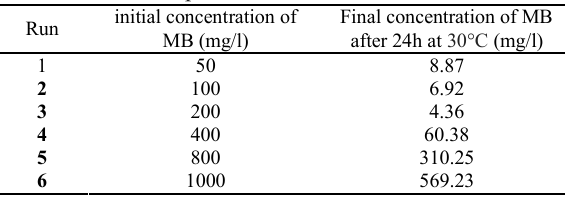
Table 1 The initial and final concentration of MB in the presence of bacteria